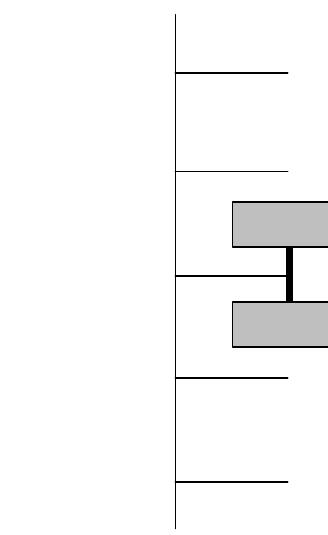
Figure 2. Schematic representation of the modes of interaction of a cyclobisintercaland molecule with double-stranded (left) and single-stranded (right) nucleic